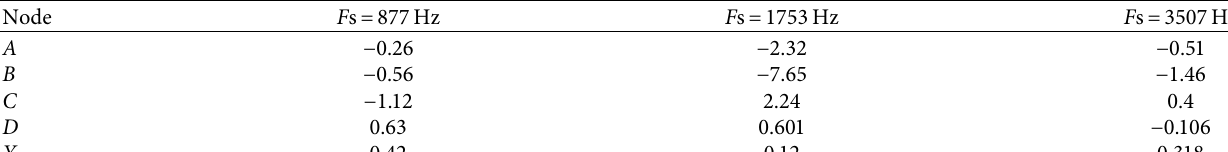
Figure 8: Pseudo-frequency vs. captured harmonic power for 5th, 6th,7th harmonics. Table 8: DWT outcomes for 6-pulse and 12-pulse converter positioned at node D node B, respectively.